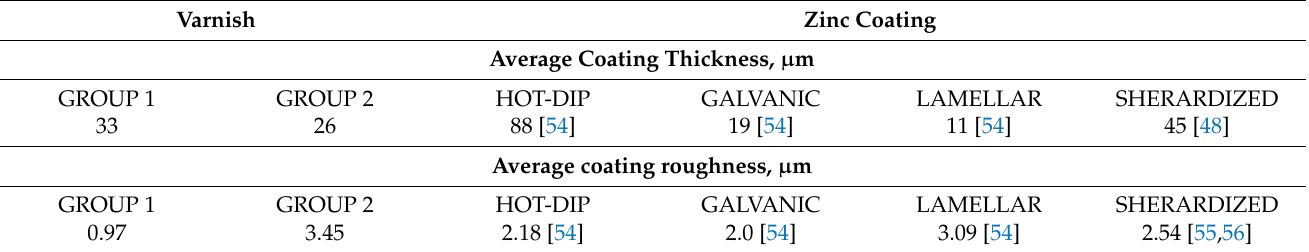
Table 2. Comparison of the varnish and zinc average coating parameters.